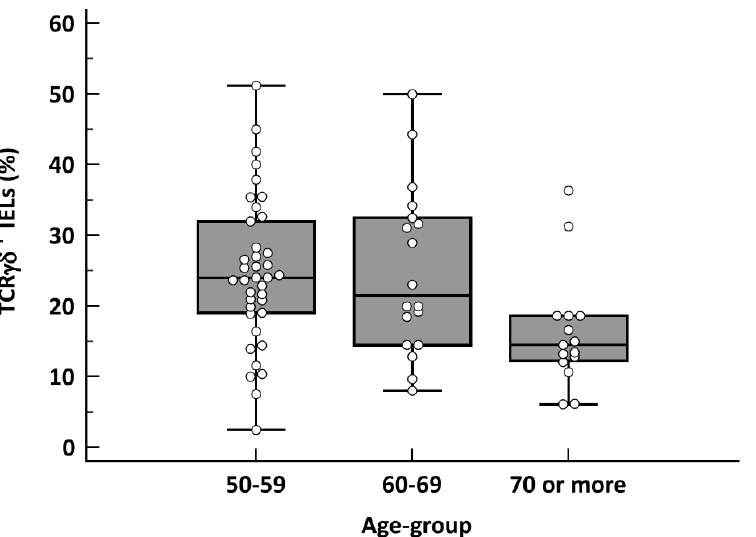
Figure 1. Box-plot chart of TCR γδ + cells in CD patients with villous atrophy ( n = 71), depending on the different age groups ( p = 0.009; Kruskal–Wallis test). Figure 2. Box-plot chart of CD3- cells in CD patients with villous atrophy ( n = 71), depending on the different age groups ( p = 0.25; Kruskal–Wallis test).